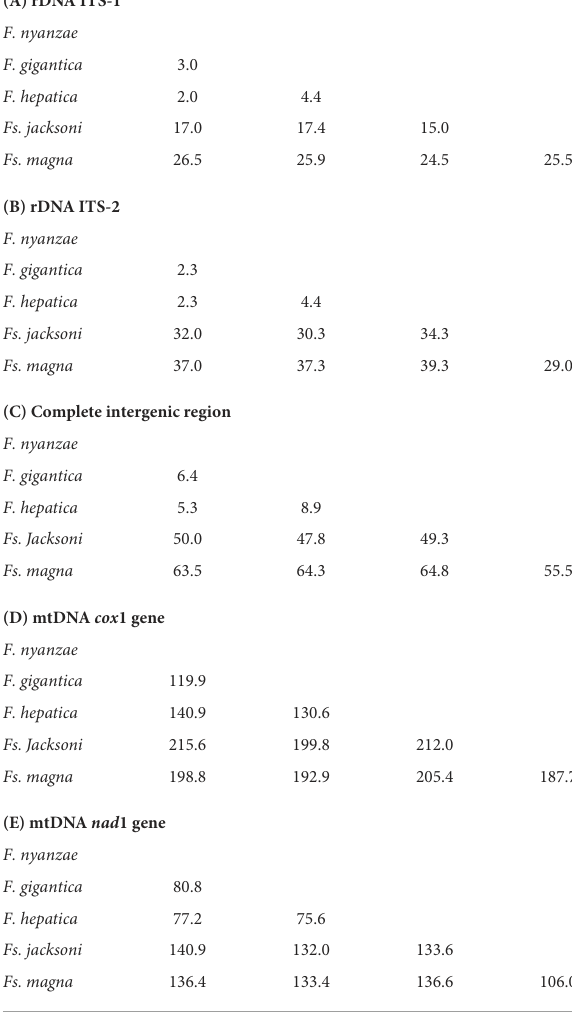
TABLE 5 Estimates of evolutionary divergences over sequence pairs between species groups in the complete sequences of the nuclear rDNA and mtDNA